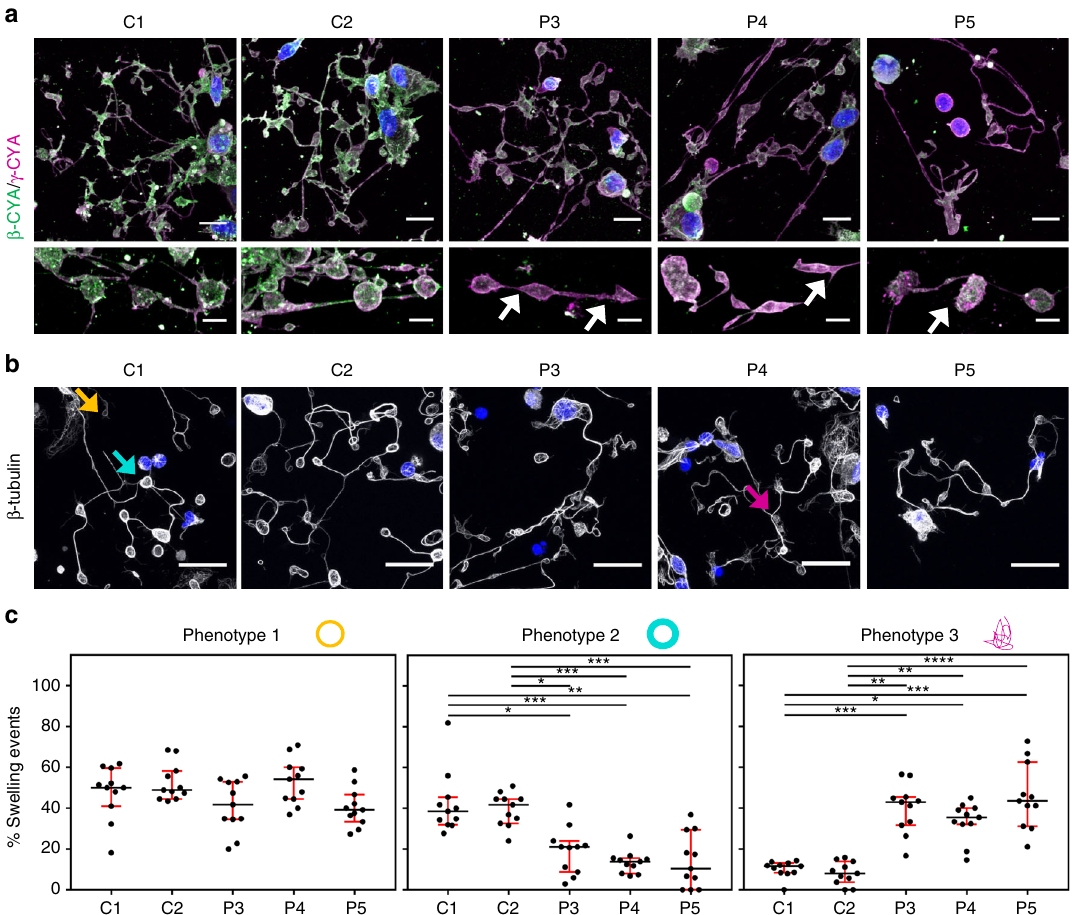
Fig. 8 Microtubule organization in proplatelet swellings is compromised in ACTB -AST-derived megakaryocytes. a β -CYA (green) and γ -CYA (magenta) distribution in proplatelet-forming MKs from PBMCs isolated from the whole blood of two healthy controls (C1 and C2), patient 3 (P3), patient 4 (P4), and patient 5 (P5). Representative maximum intensity projections show reduced incorporation of β -CYA into proplatelet structures in ACTB -AST cells. White arrows indicate irregular-shaped proplatelet swellings identi fi ed in patient samples. Scale bars are 10 µ m for the top row and 5 μ m for the bottom row; b Representative images of β -tubulin labeled MKs from C1, C2, P3, P4, and P5. Arrows indicate the three proplatelet swelling phenotypes observed, where microtubules are (1) organized into a thin marginal band (yellow arrow), (2) organized into a thick marginal band (cyan arrow), or (3) disordered (magenta arrow). Scale bars are 20 µ m; c Quanti fi cation of the percentage of proplatelet-attached swellings with thin marginal bands (phenotype 1, left), thick marginal bands (phenotype 2, middle) and disordered microtubules (phenotype 3, right) shows signi fi cant differences between healthy controls and ACTB - AST patients. For each condition, blinded analysis of 11 images from 3 samples obtained from 1 experimental repeat was performed. Data are represented as median (IQR). Signi fi cance was determined with the Kruskal – Wallis test, where * p < 0.05, ** p < 0.01, *** p < 0.001, **** p